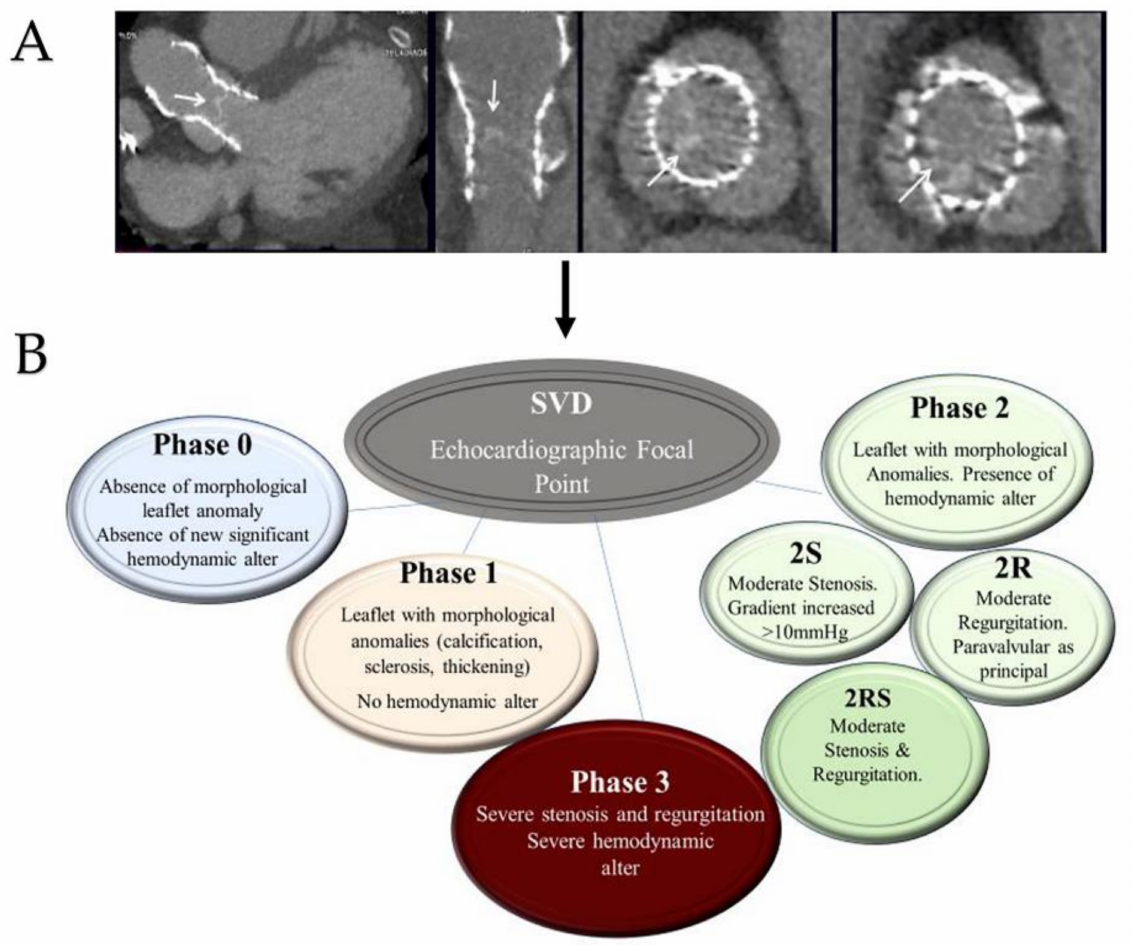
Figure 9. ( A ): Early SVD with calcifications (white arrow) of TAVI in patient receiving self-expanded first-generation CoreValve 26 mm (CoreValve, Minneapolis, Minnesota). ( B ): Classification of SVR based on recommendations of the VARC-2 for stent/stentless xenograft. The useful elements to define SVD as valve-related dysfunction were the mean aortic gradient ≥ 20 mm Hg, the effective orifice area ≤ 0.9–1.1 cm 2 , a dimensionless valve index <0.35 m/s, and moderate or severe pros- thetic regurgitation. Phase 0 displays the absence of morphological leaflet anomaly and absence of hemodynamic alteration. Phase 1 discloses early morphological changes without hemodynamic compromise. The morphological alterations typical of stage 1 are also referable to prostheses where the degenerative process is controlled using antithrombotic drugs that reduce the thickening of the leaflet. Phase 2 reveals morphological abnormalities of valve leaflets of SVD associated with hemody- namic dysfunction. The bioprosthesis in this phase can manifest as stenosis or regurgitation. The thrombosis is a factor favoring phase 2, leading to stenosis or paravalvular leakage and regurgitation. Phase 2 includes two subcategories, phase 2S and phase 2R. In the evolutive stage of 2S degeneration, an increase in the mean transvalvular gradient ( ≥ 10 mm Hg) and decrease in the valvular area without leaflet thickening occur. SVD may occur in the 2RS form including moderate stenosis and moderate regurgitation. Phase 3 of SVD highlights severe stenosis or severe regurgitation with severe hemodynamic change. Abbreviations: R, regurgitation; SVR, structural valve degeneration; S, stenosis; VARC, Valve Academy Research